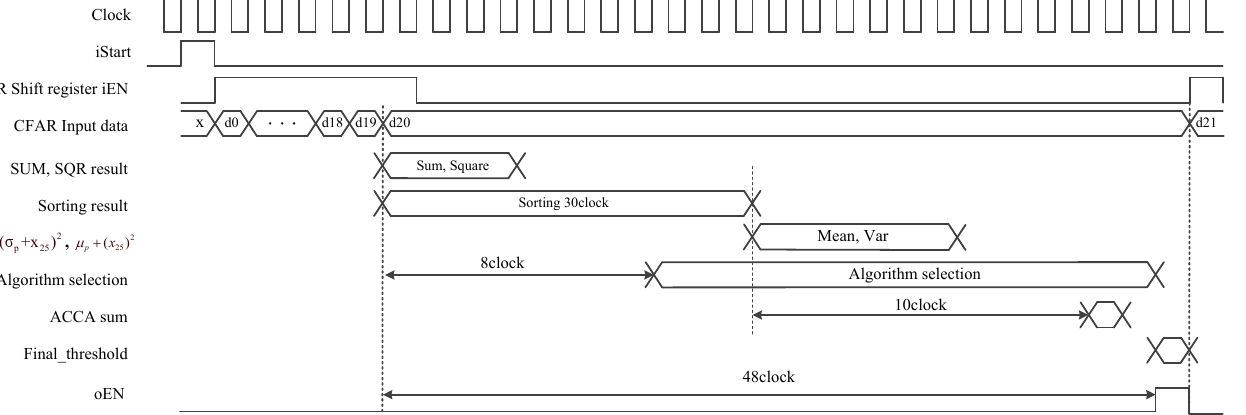
Figure 20. Timing diagram of the proposed CFAR processor.